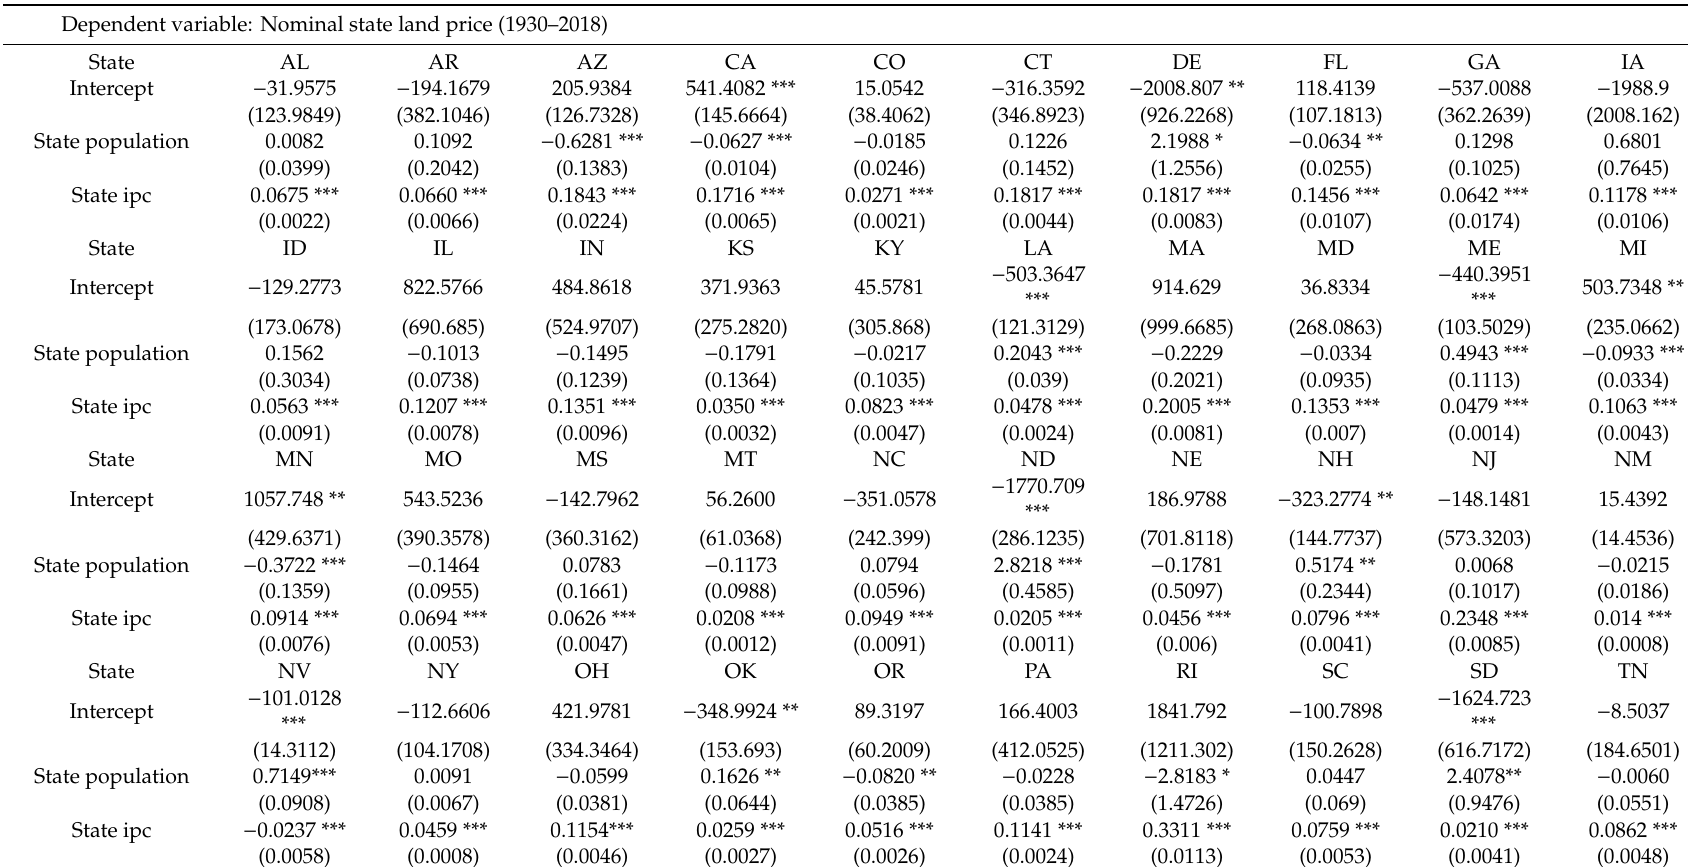
Table A1. The impact of state level population and income per capita on nominal agriculture land price, nominal